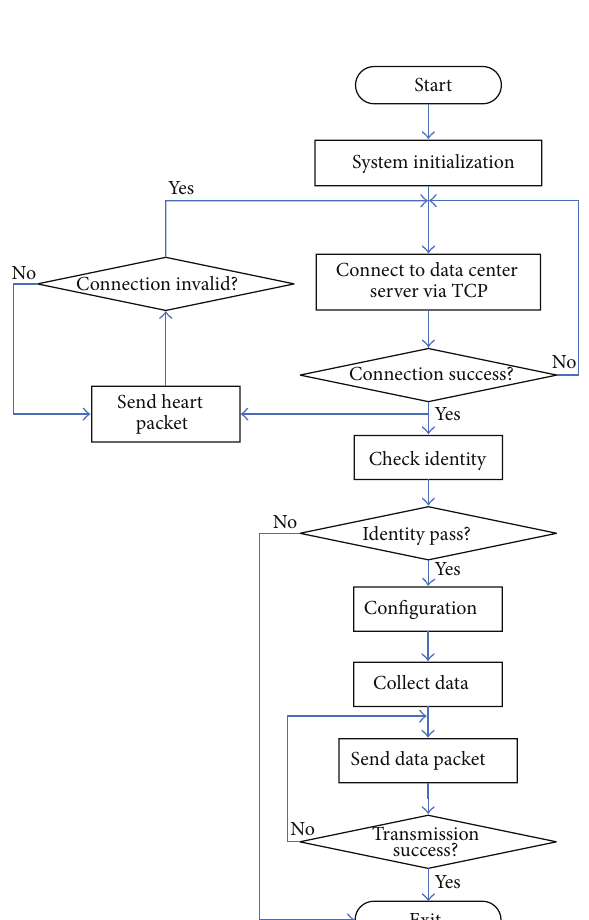
Figure 3: Flow chart of system